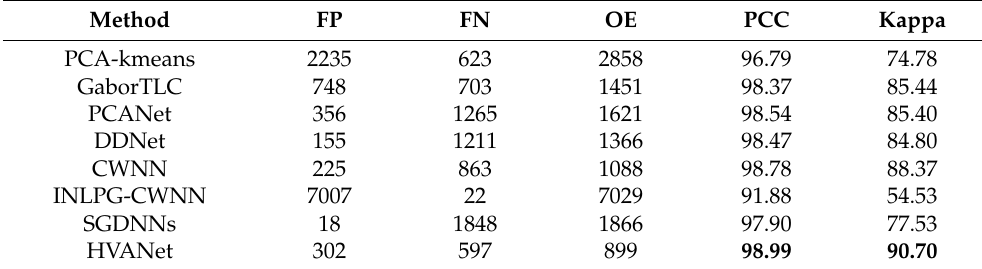
Table 10. Change detection results of each method on the Farmland B dataset.